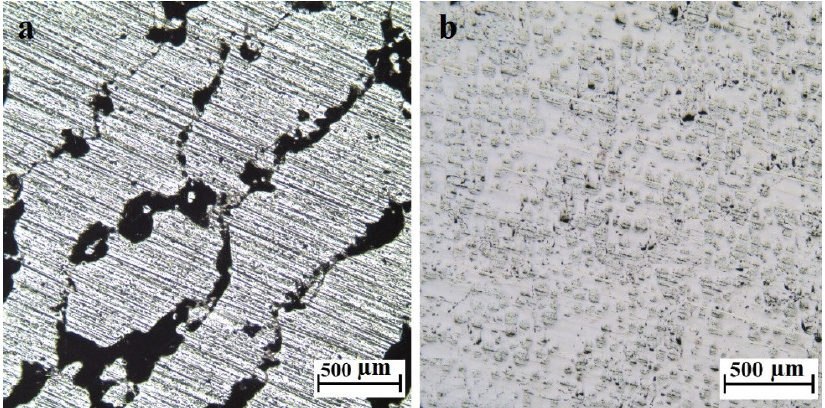
Figure 8. Microstructure of the cross-section of the deposited layers after LDED (×50): ( a ) powder PM-M; ( b ) powder PMS-M99.9.